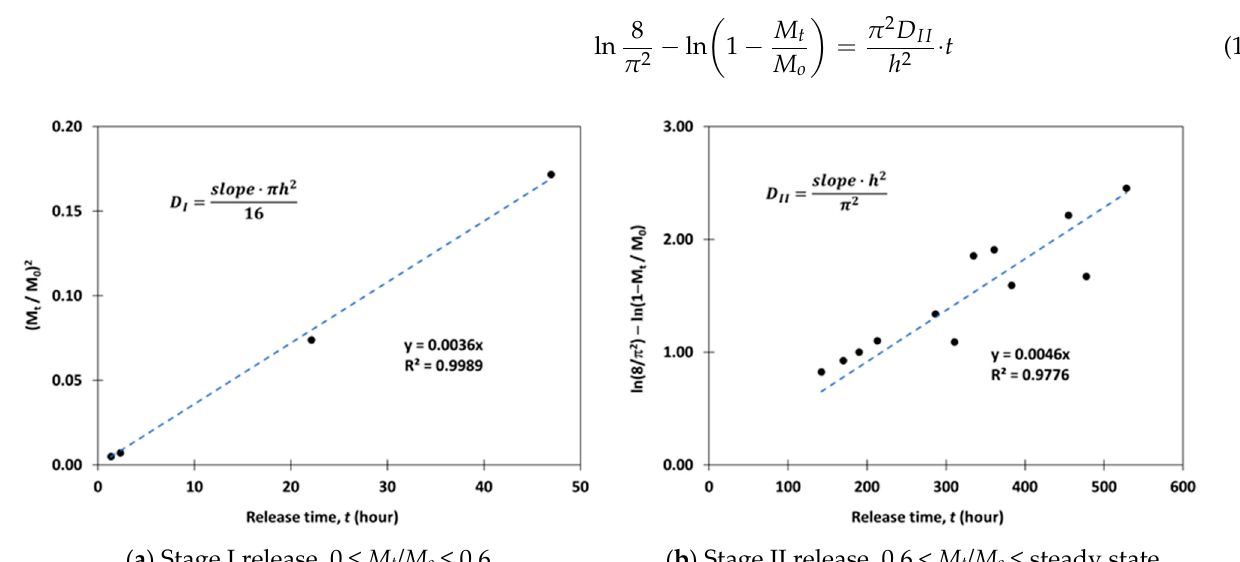
Figure 2. Examples of di ff usion coe ffi cient estimations using Fick’s law and drug release data.